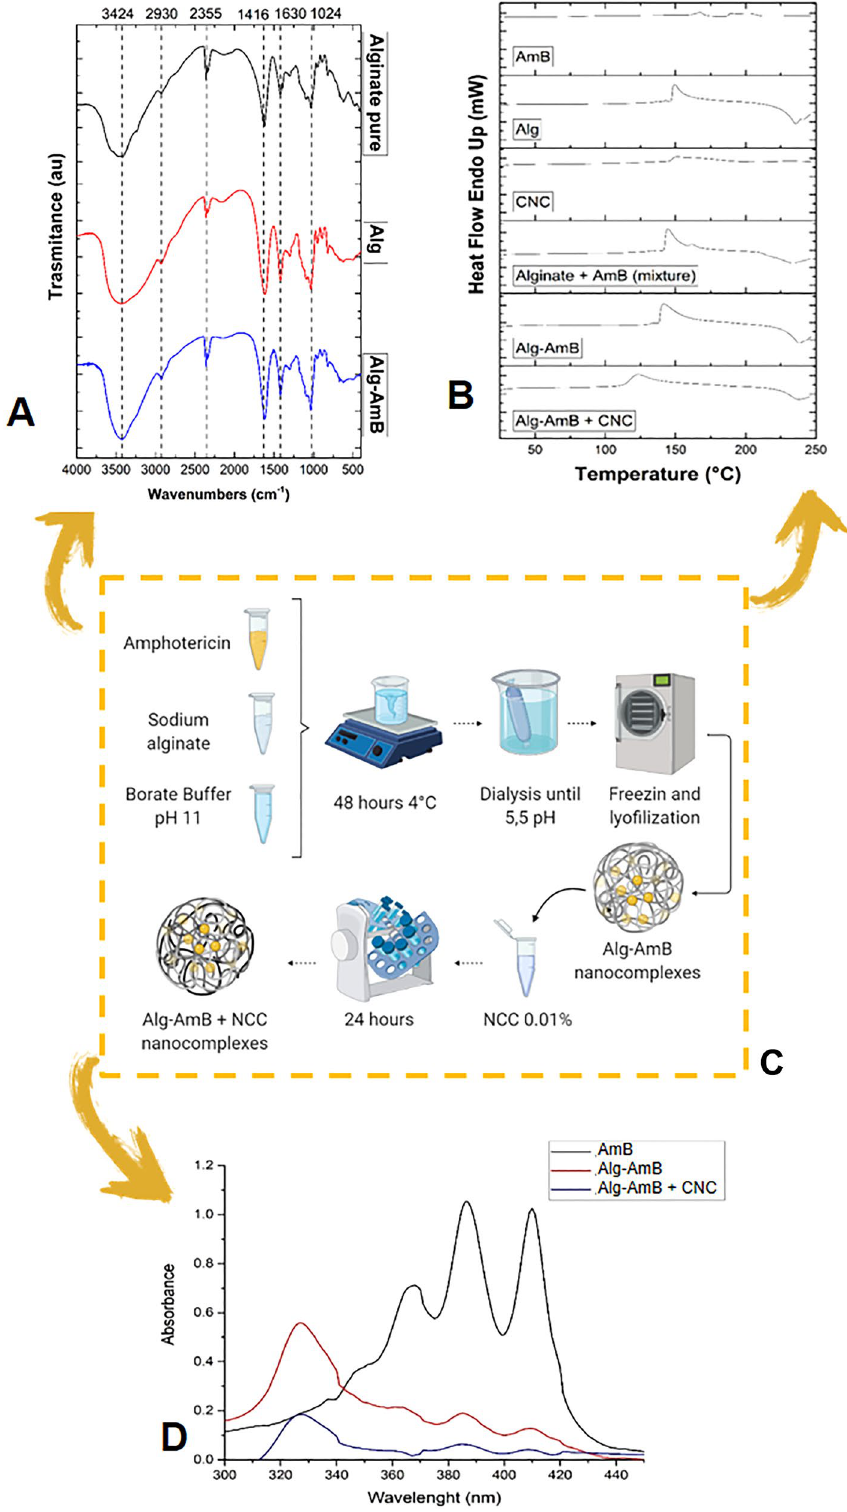
Figure 1. ( A ) Differential Scanning Calorimetry (DSC). ( B ) Infrared spectrum by Fourier transform (FTIR). ( C ) Design Production of Alg-AmB and Alg-AmB + CNC. ( D ) UV–Vis spectrometry. Note: A – DSC analysis of AmB, Alg, CNC, alginate + AmB (mixture), Alg-AmB and Alg-AmB + CNC. B – FTIR of pure alginate, Alg and Alg-AmB. D – UV–Vis spectrometry of the AmB, Alg-AmB and Alg-AmB +